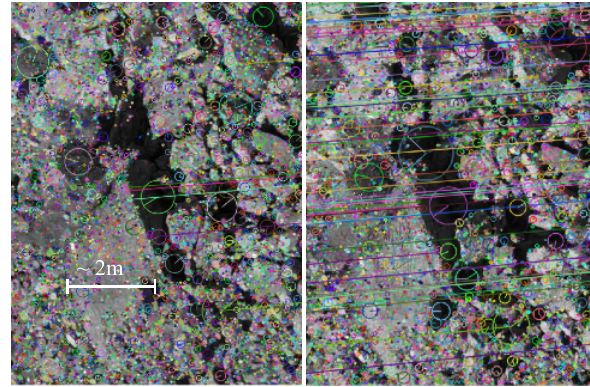
Figure 4. OpenCV Tie point matching (SURF)